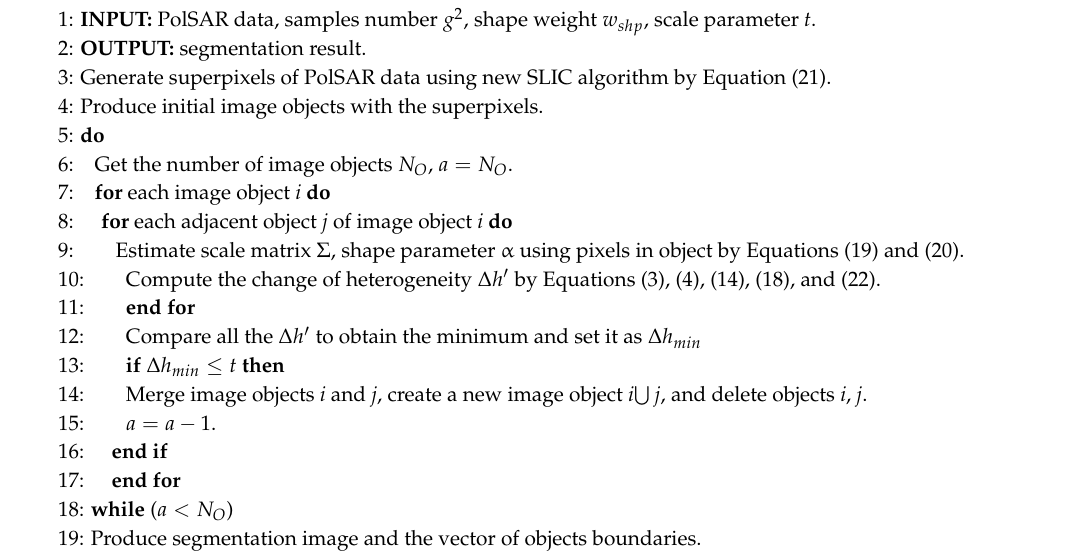
Algorithm 1. FNEA-based Multi-Feature PolSAR